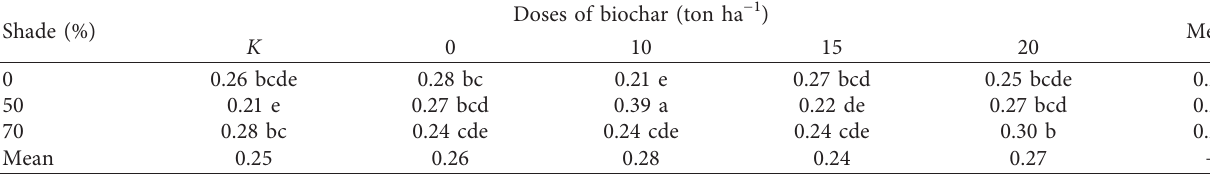
Table 7: Effects of biochar and shade application on the available calcium (cmol (+).kg − 1 ).